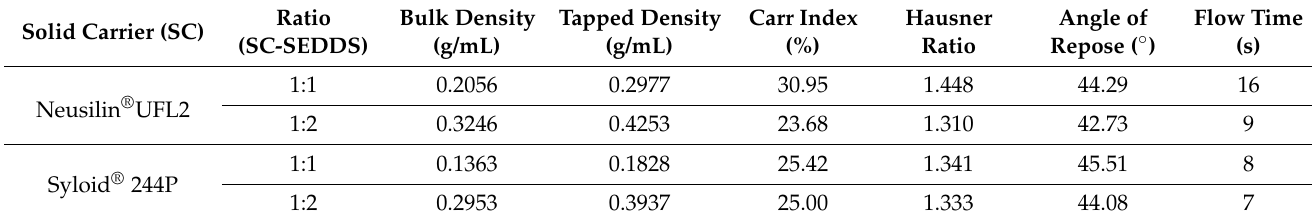
Table 11. Micromeritic properties of prepared solid